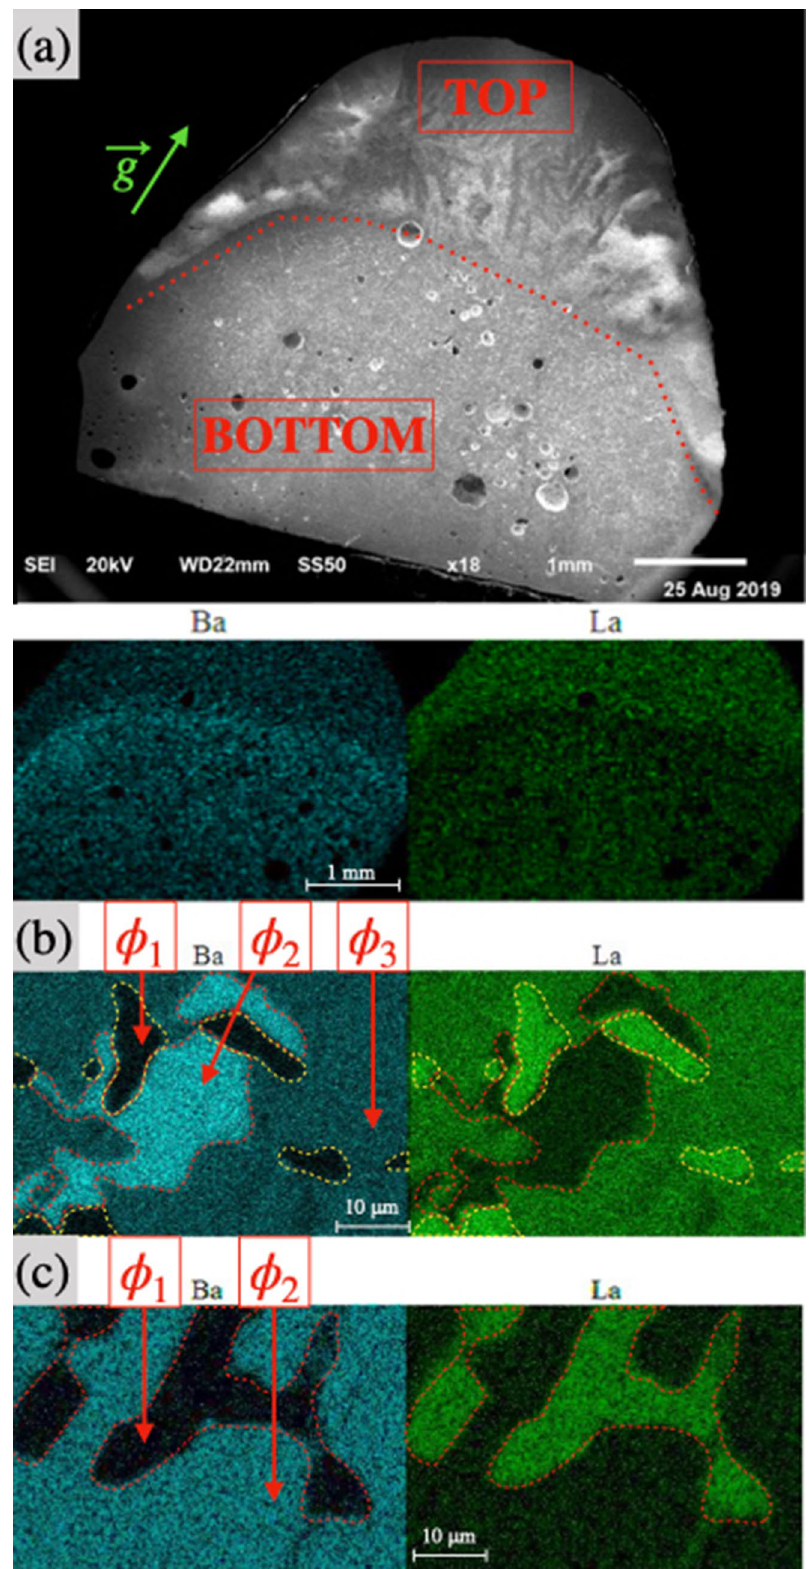
Figure 6. ( a ) SEM equipped with a single EDS detector images of (BaS) 0.30 - ( La 2 S 3 ) 0.70 sample acknowledging different macrophases; ( b ) example of φ 1 , φ 2 and φ 3 phase separation for (BaS) 0.25 - ( La 2 S 3 ) 0.75 samples; ( c ) example of φ 1 , φ 2 phase separation for (BaS) 0.30 - ( La 2 S 3 ) 0.70